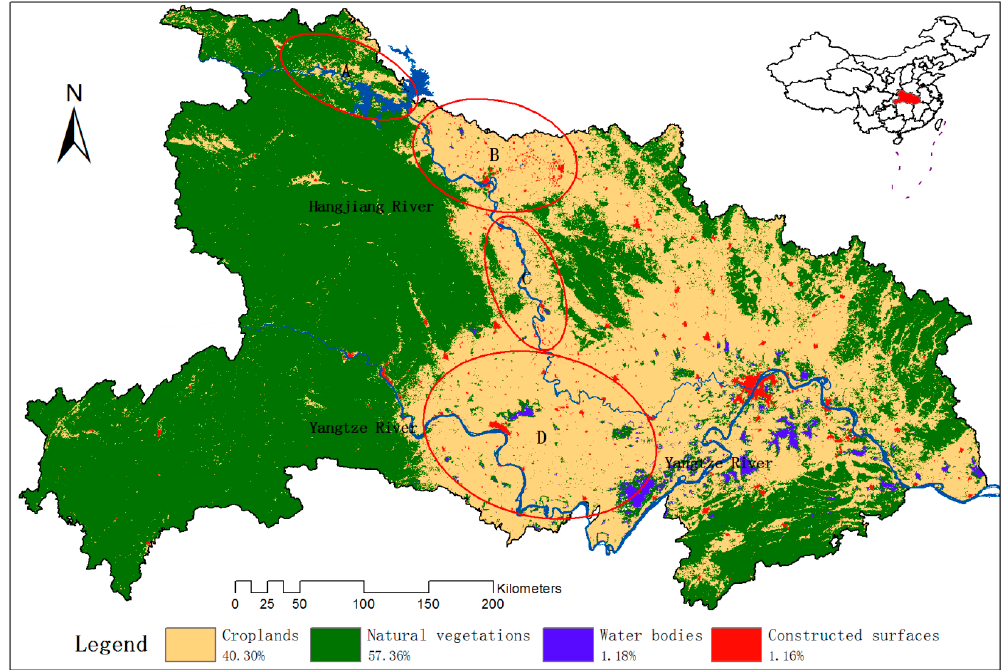
Figure 1. The research area and the main land-cover classes in 2010 from MCD12Q1 UMD datasets, which was from the standard Moderate Resolution Imaging Spectroradiometer (MODIS) land cover type data product in the IGBP Land Cover Type